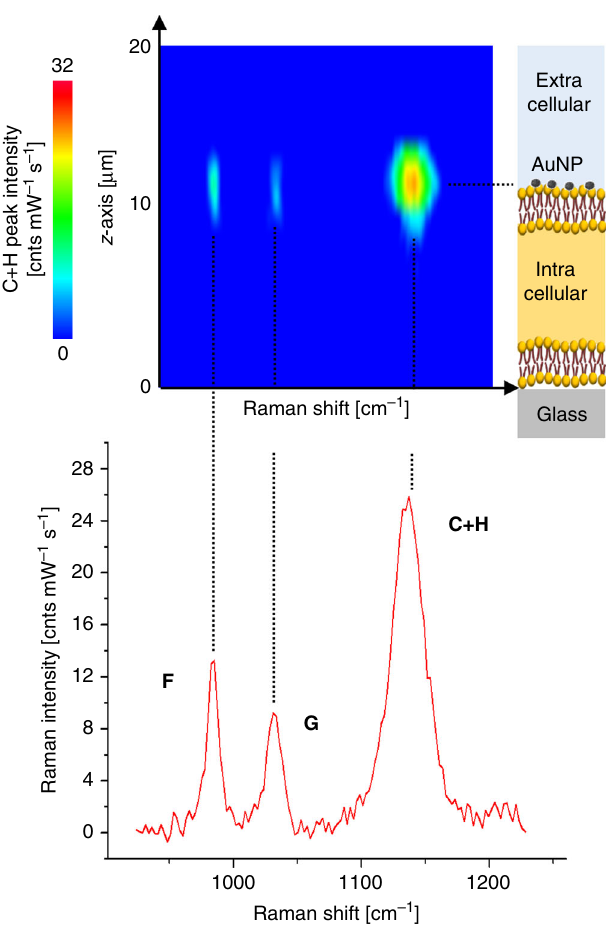
Fig. 8 Visualization of AuNP anchored to the cell membrane by SERS. Typical results of SERS spectral intensity as collected from a z -axis line scan performed in the middle of a MKN28 cell after AuNP anchoring. The intensities in the range 925 – 1230 cm − 1 are shown as a function of the position along the z -axis. The z = 0 position corresponds to the bottom of the cell, which was identi fi ed by focusing the laser on the glass bottom dish. The symmetric shape of the SERS intensity distribution of each band along the z -axis con fi rms the location of the nanometer pH sensor in one single position, namely the point